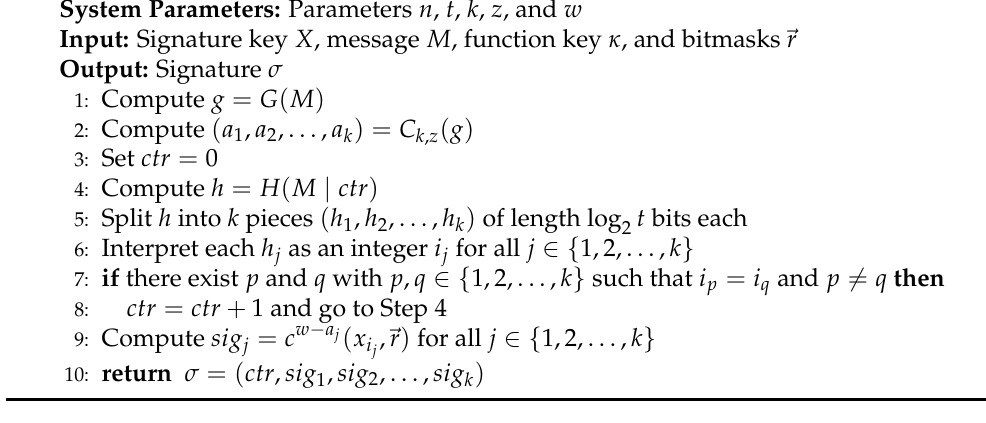
Algorithm 6: Signing of HORSIC+ ( Sign HORSIC + ( X , M , κ , (cid:126) r ) )